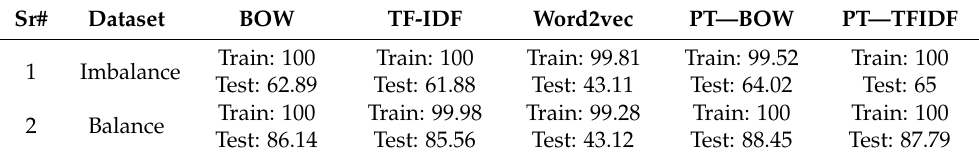
Table 4. Results of the decision tree.